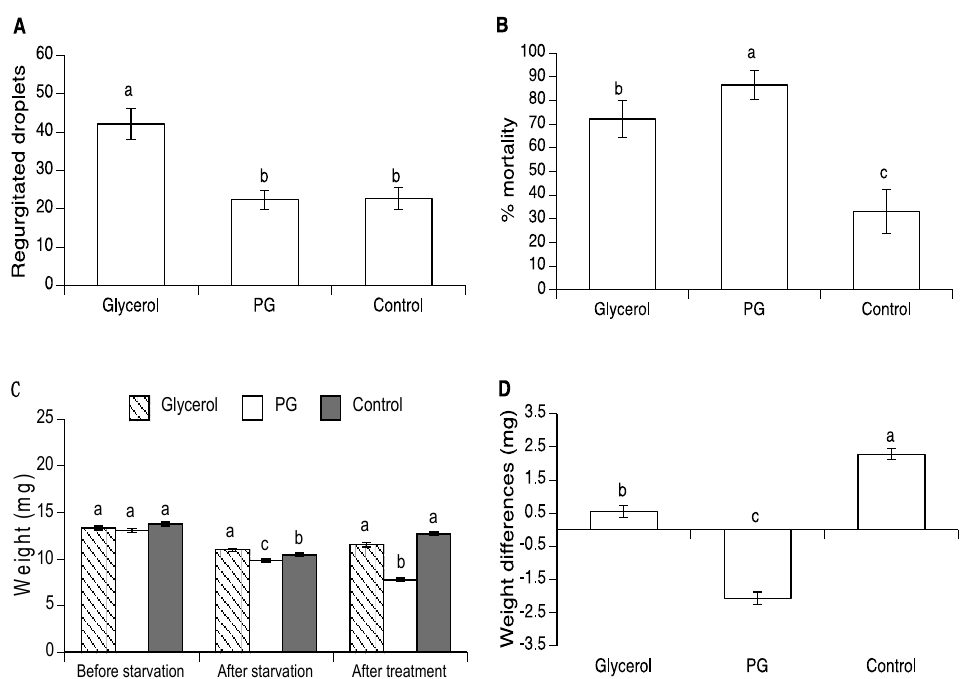
Figure 3. ( A ) Mean ( ± SE) regurgitated droplets deposited on cup walls by A. obliqua exposed to 4.18 M PG or 4.18 M glycerol in mixtures with sucrose. ( B ) Percentage of mortality. ( C ) Mean ( ± SE) fly body weight before starvation, after starvation (prior to treatment) and at 24 h after treatment. ( D ) Mean ( ± SE) difference in body weight before treatment and at 24 h post-treatment. Columns headed by the same letter are not significantly different (GLM post-hoc contrasts, at the p = 0.05 level).